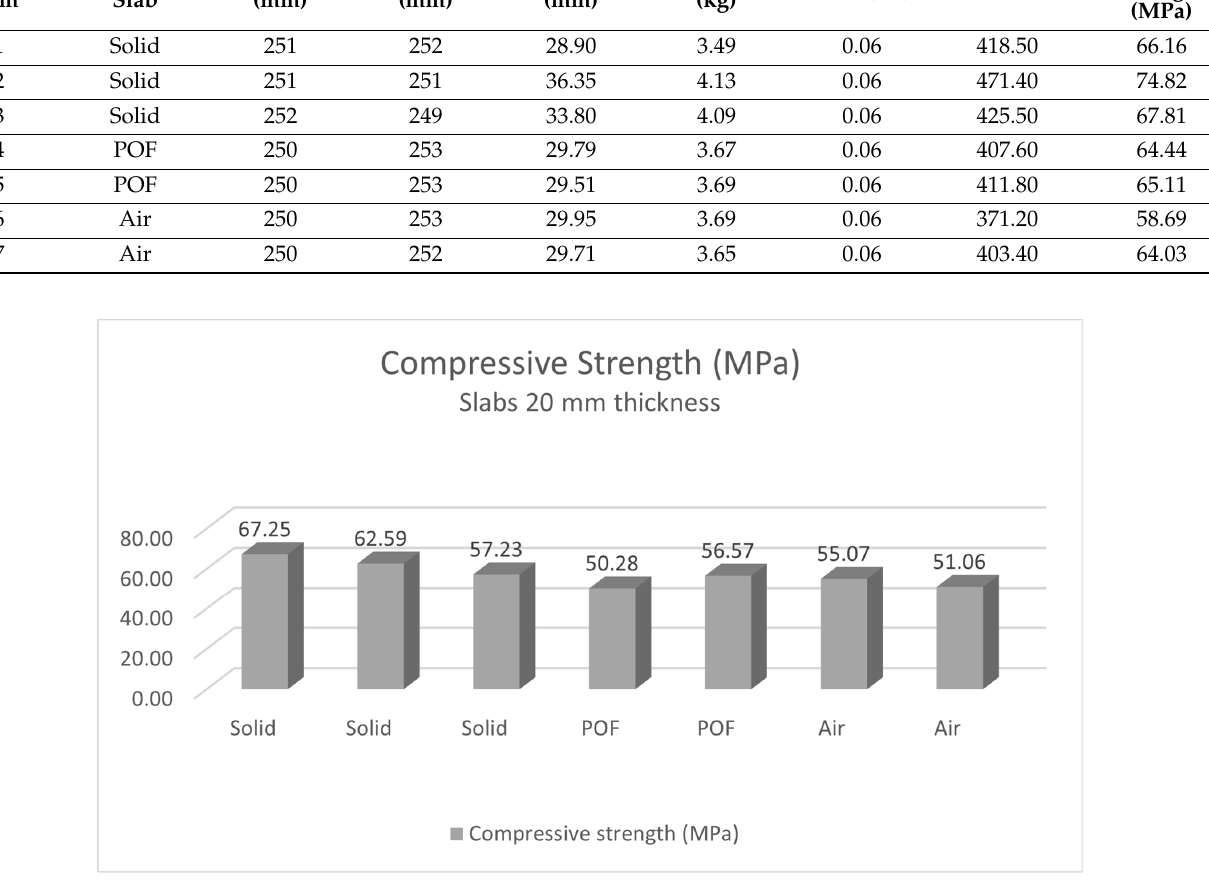
Figure 36. Compressive strength of slabs of thickness 20 mm.